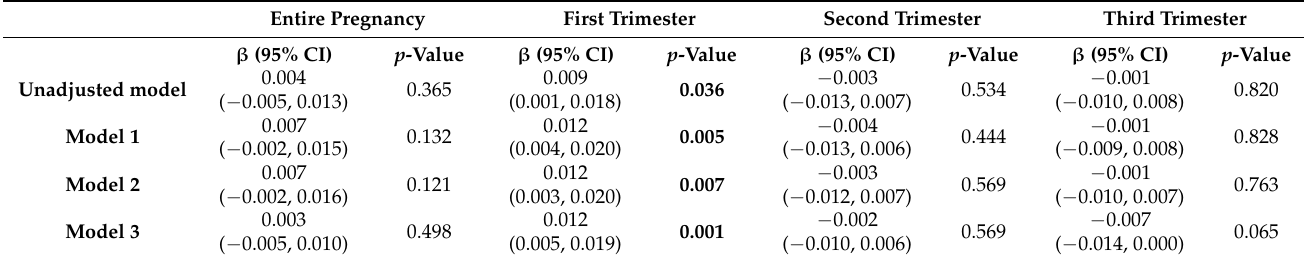
Table 3. Maternal total vitamin D intake (diet + supplement) during the first, second, and third trimester and entire pregnancy and average relative telomere length (TL) of the